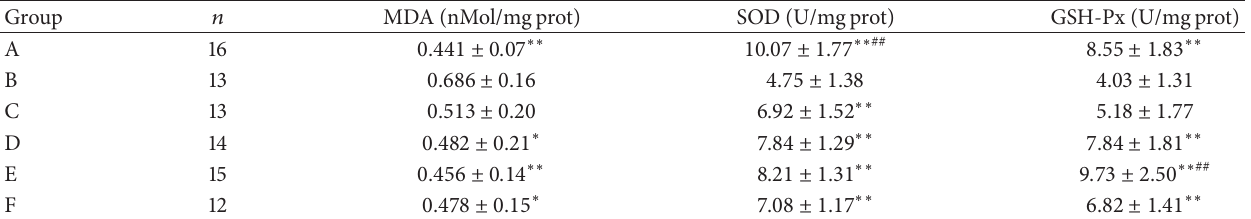
Table 4: The effect of rHV3 eye drops on the activities of MDA, SOD, and GSH-Px in the lens on diabetic cataract in Sprague-Dawley rats ( 𝑥 ± 𝑠 ).